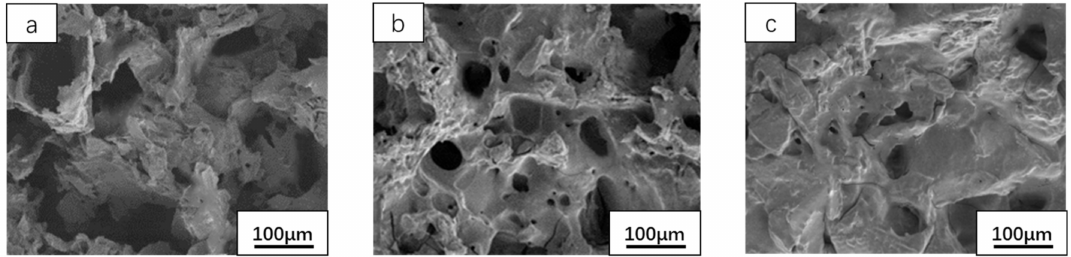
Figure 5. SEM morphology of carbon layer after combustion: ( a ) control PS, ( b ) PS-20%IFR, ( c ) PS-